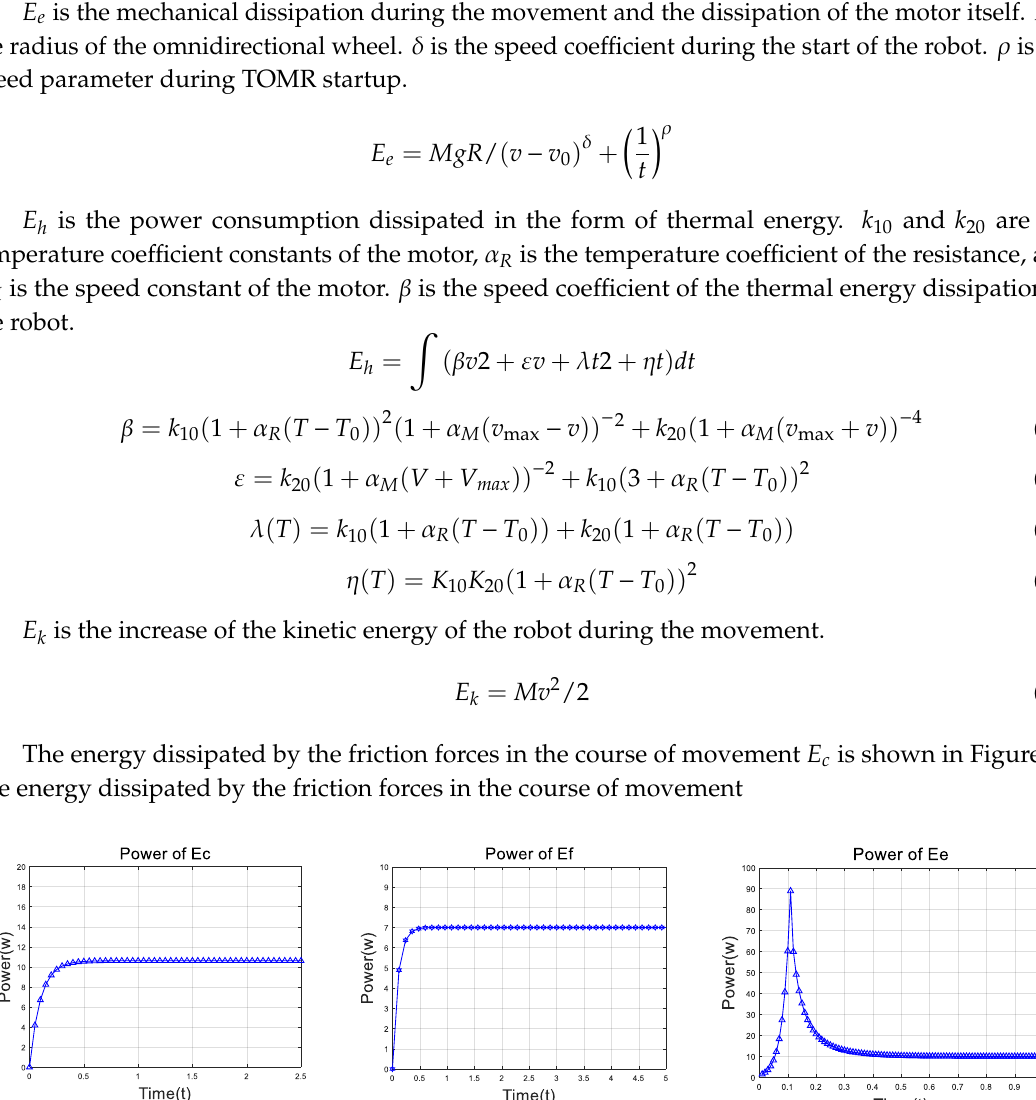
( b ) Figure 6. Ek and Eh change versus time. ( a ) Ek changes versus time, ( b ) Eh changes versus time. The parameters of the motor and drive wheel of the measuring robot are shown in Table 1 Table 1. TOMR drive wheel parameters. Parameter